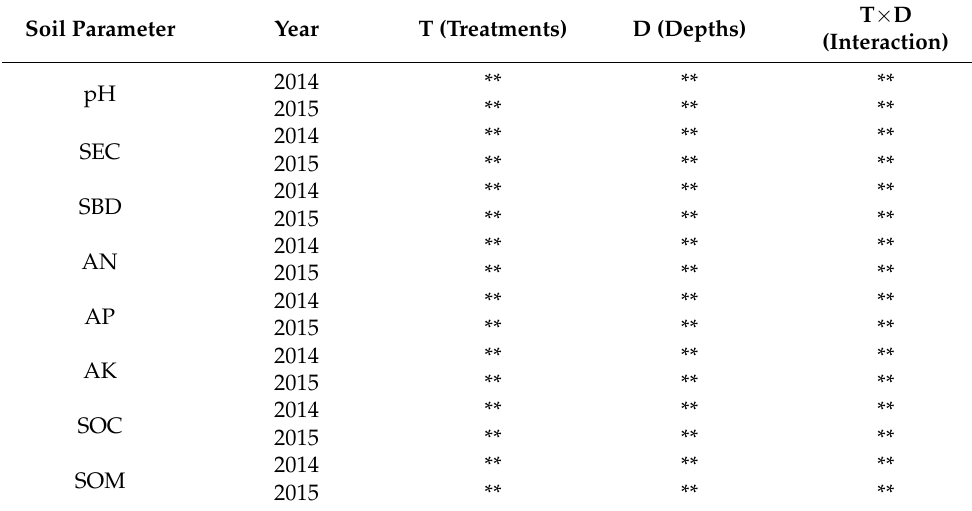
Table 2. Analysis of variance (ANOVA) for the effects of BHA treatments and soil depths on soil pH, SBD, SEC, and nutrients.